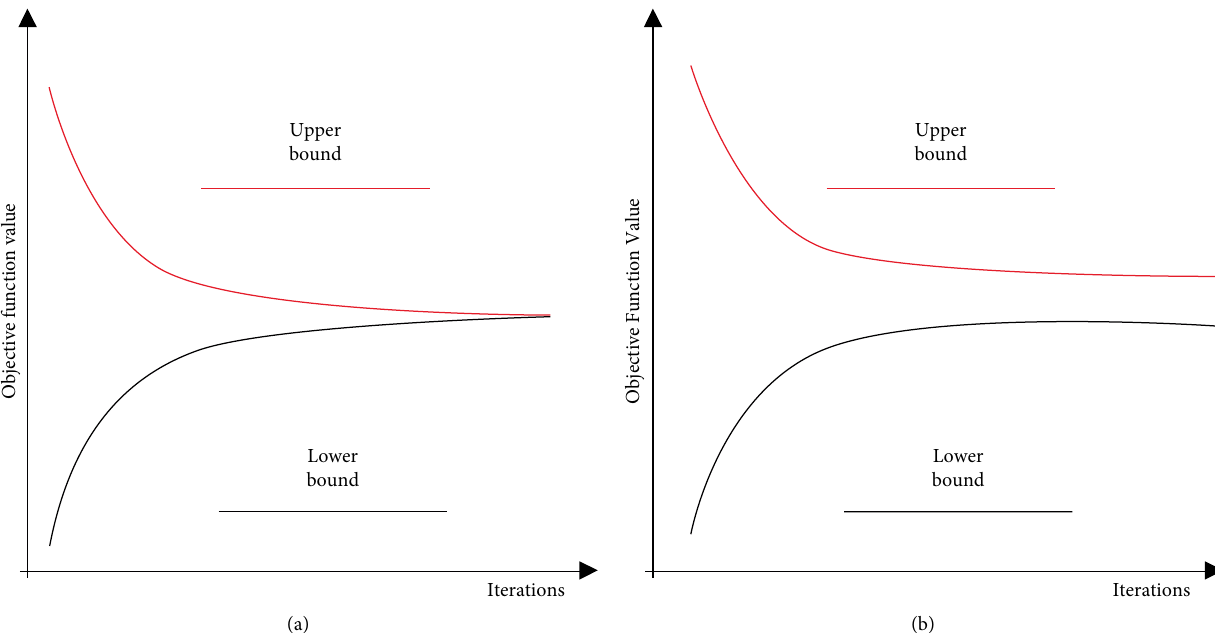
Figure 5: A scheme of the Lagrangean Relaxation method solved through the subgradient algorithm. The first figure represents a scenario that the optimal solution was found because the LB and UB achieved the same value. On the contrast, the second figure represents a scenario that the optimal solution was not found.